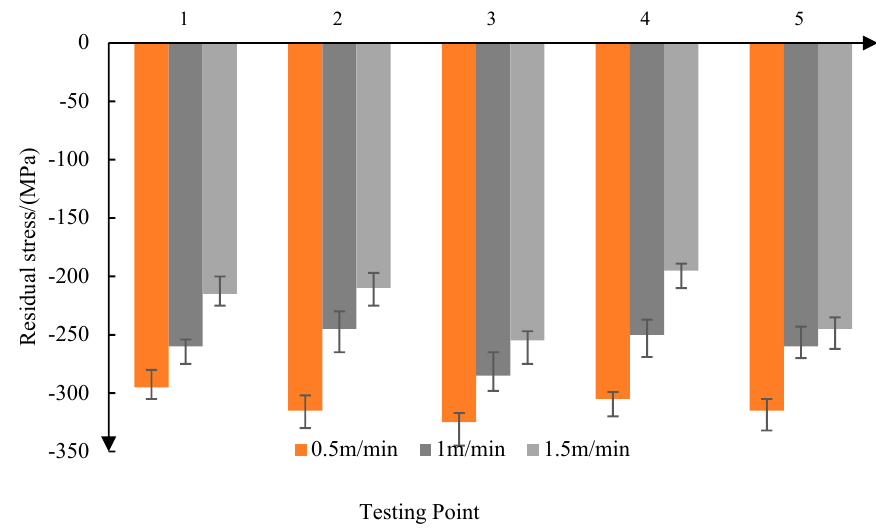
Figure 7. Effect of feed rate on residual stress.